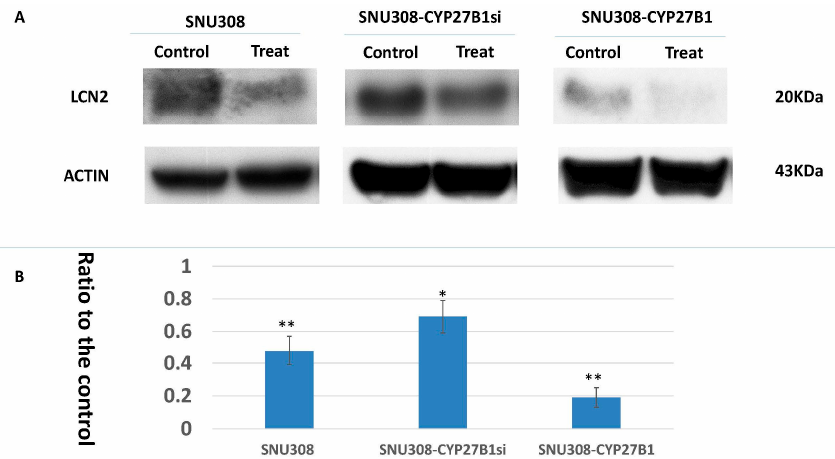
Figure 2. Evaluation of 25(OH)D effect on LCN2 expression in SNU308 cells with or without modulation of CYP27B1 gene expression. ( A ) A Western blot depicting LCN2 expression in SNU308, SNU308-CYP27B1si, and SNU308-CYP27B1 cells after two days of 10 − 6 M 25(OH)D treatment; ( B ) Quantitative analysis of LCN2 expression. Each value is a mean ± SD of three to five determinations. * p < 0.05, ** p < 0.001 versus control.